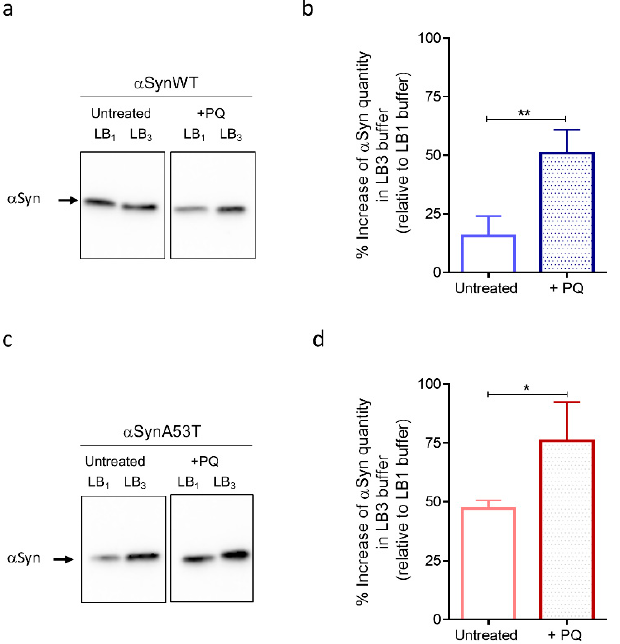
Figure 6. Fly chronic exposure to PQ affects soluble α Syn detection in denaturating buffers. Western blot (antibody MJFR1) analysis on fly head extracts from control (untreated) or PQ exposed (+PQ) flies expressing α SynWT ( a , b ) or α SynA53T ( c , d ) realized at LT50. Heads (n = 100) were homogenized using a lysis buffer 1 (LB10.5% NP40) or a chaotropic lysis buffer 3 (LB3 urea/thiourea). The optical density of each sample was measured and normalized using a β -tubulin run on the same gel. The graphs are composites of six independent experiments (n = 3 for α SynWT and n = 3 for α SynA53T). The data, shown as mean with standard deviation in ( b , d ), represent the increase of the signal quantify with LB3 urea/thiourea compared to LB10.5% NP40 for a same experimental condition. P -values of the group differences were calculated using t test (** p = 0.0045 for α SynWT and * p = 0.0203 for α SynA53T).